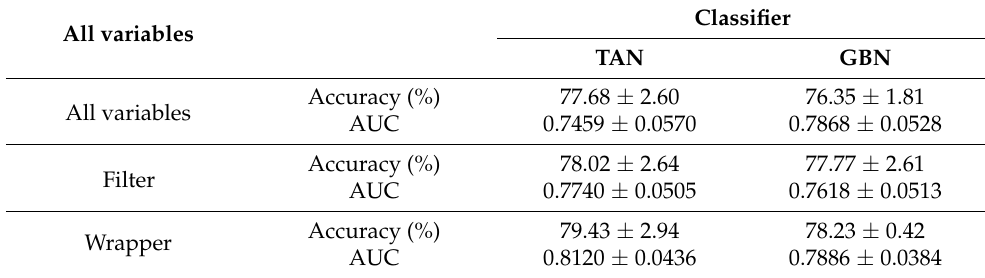
Table 3. Classification accuracy and the AUC of Bayesian network classifiers .